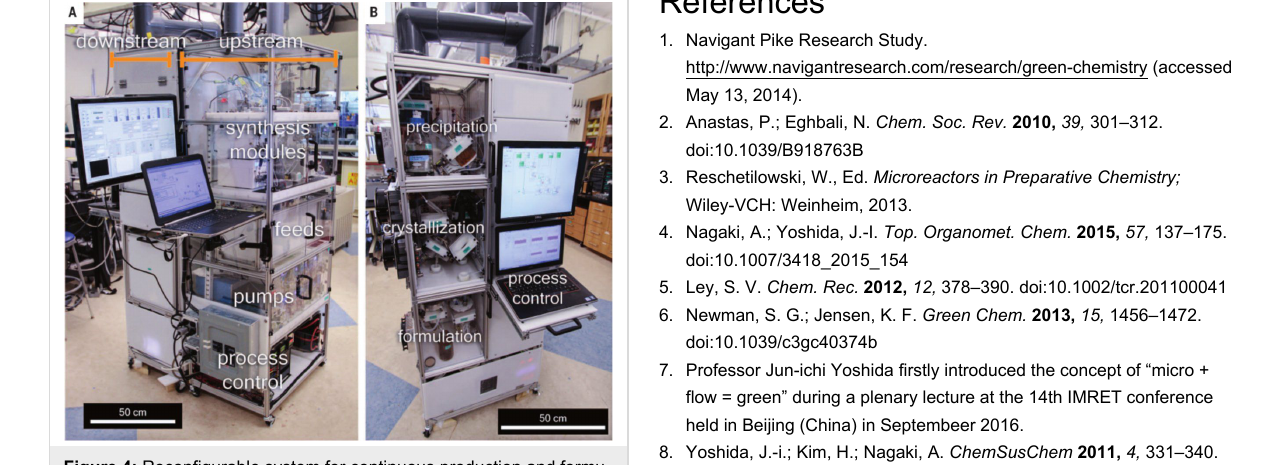
Figure 4: Reconfigurable system for continuous production and formu- lation of APIs. (Reproduced with permission from [85], copyright 2016 American Association for the Advancement of